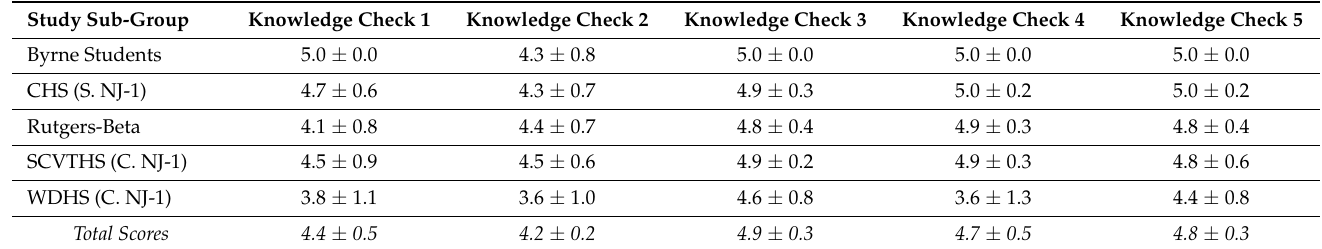
Table 3. Knowledge Check Results.